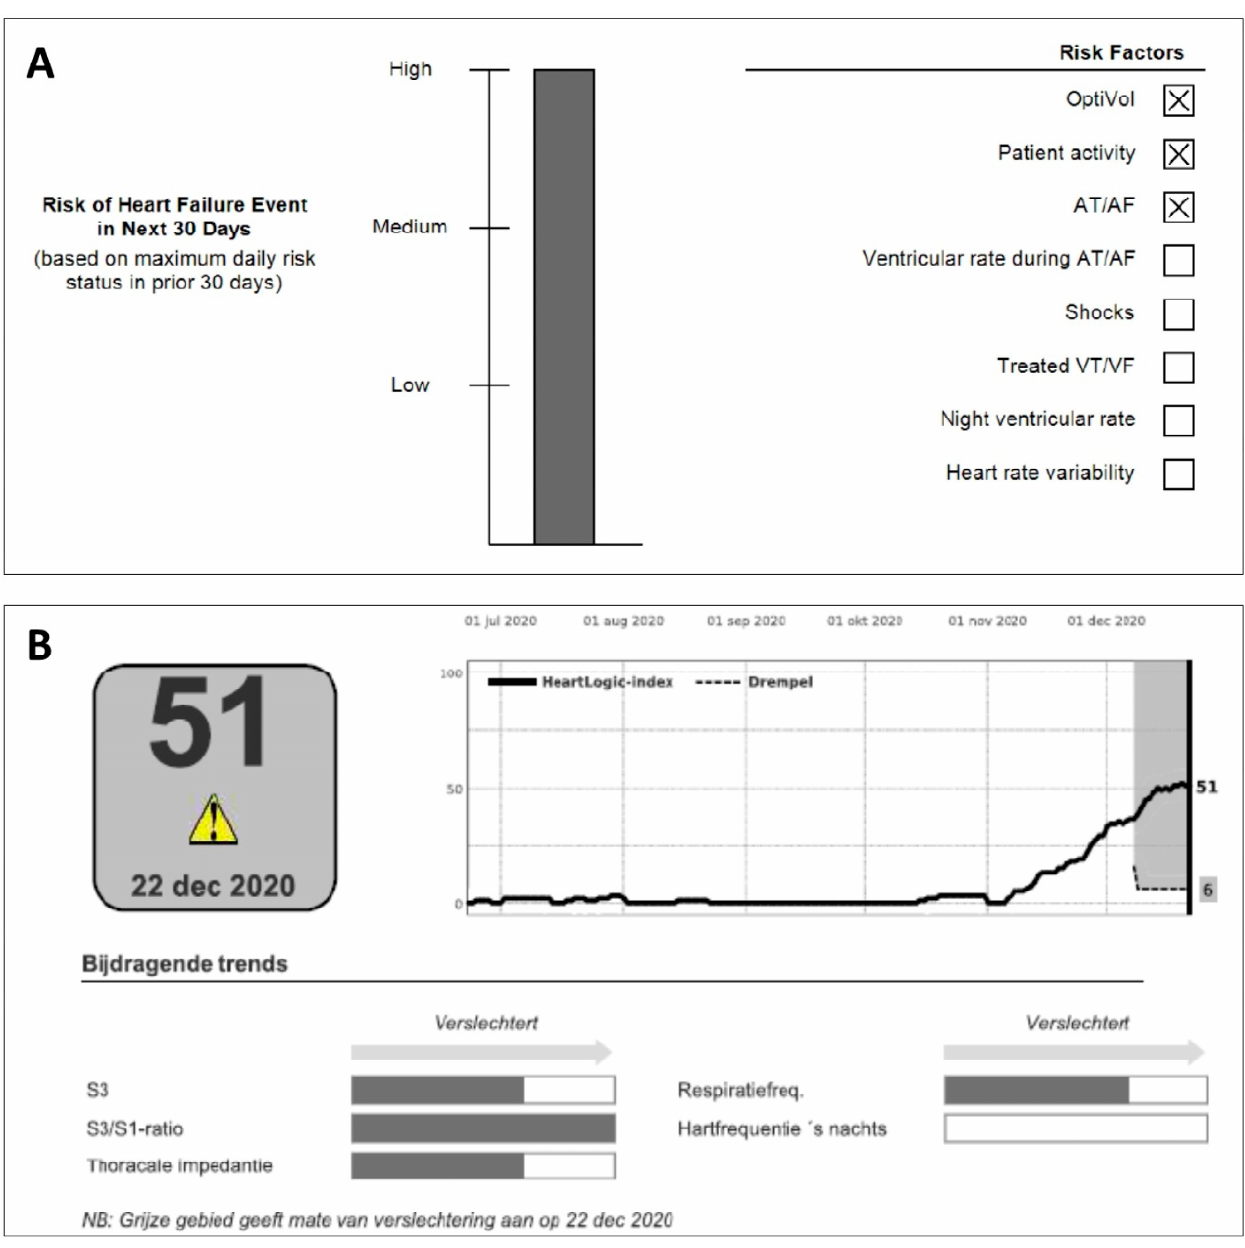
Figure 2. ( A ) TriageHF TM and ( B ) HeartLogic TM multisensory HF telemonitoring algorithm em- ployed in Medtronic and Boston Scienti fi c CIEDs, respectively.